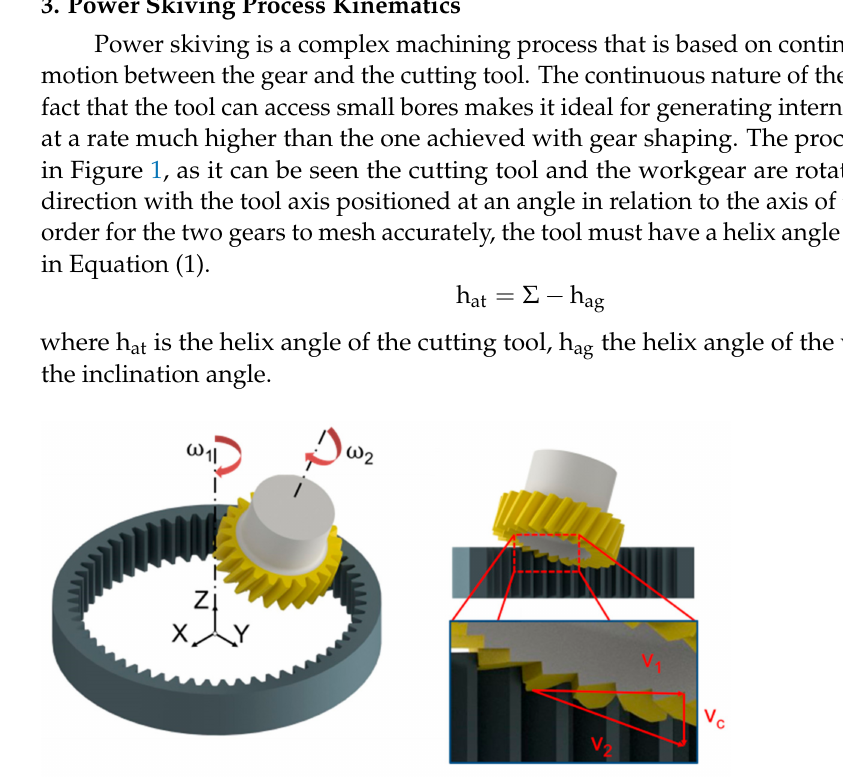
Figure 1. Power skiving